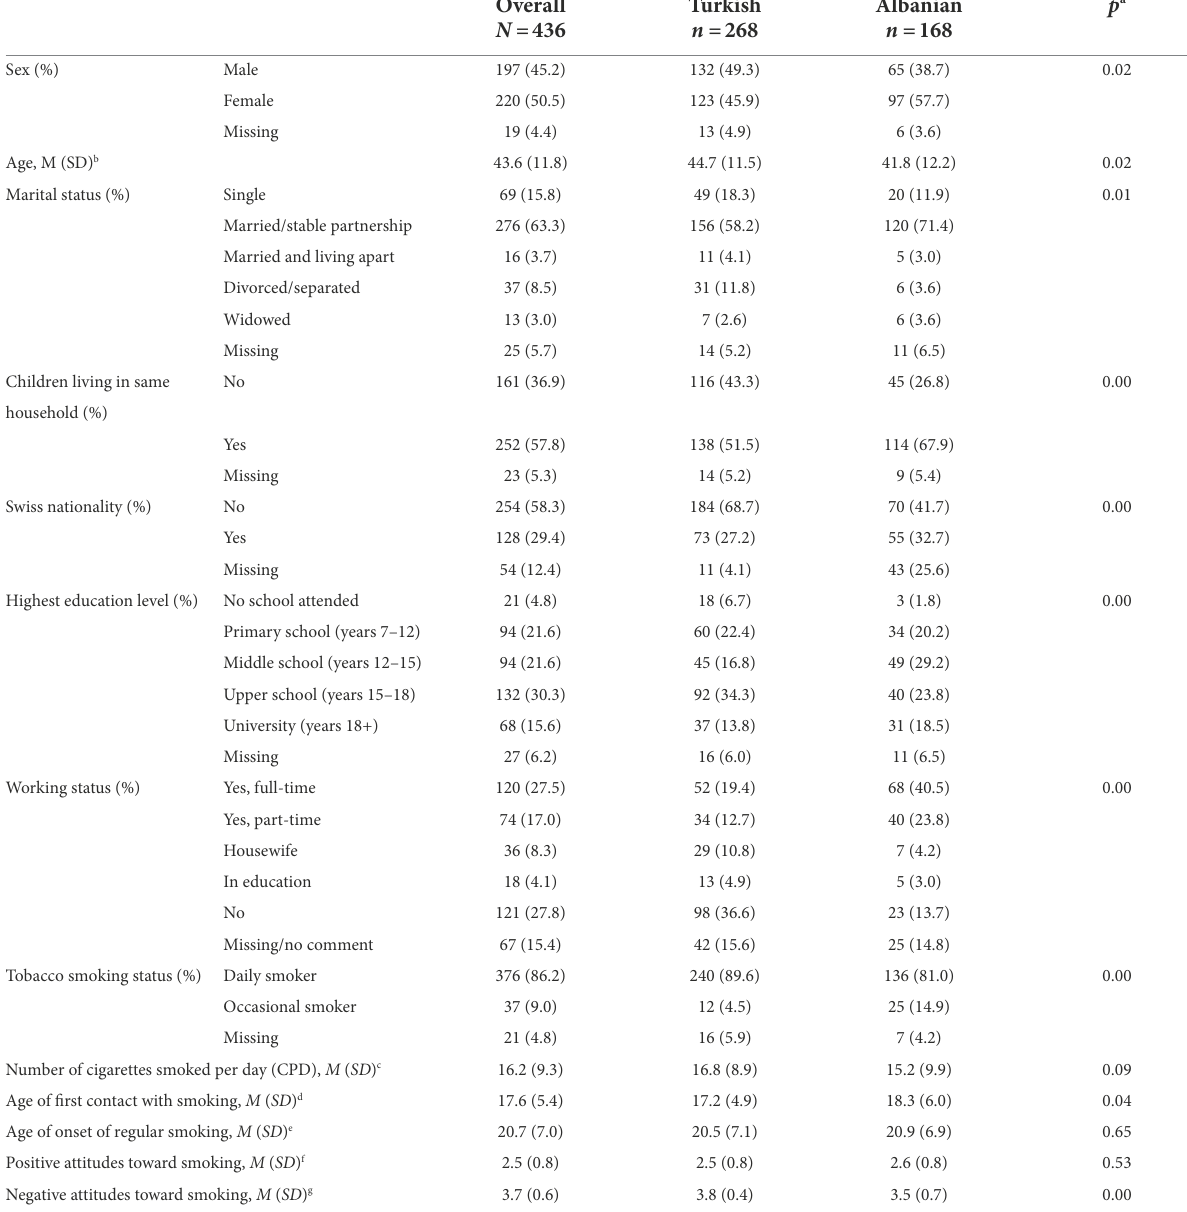
TABLE 1 Baseline characteristics of the full study